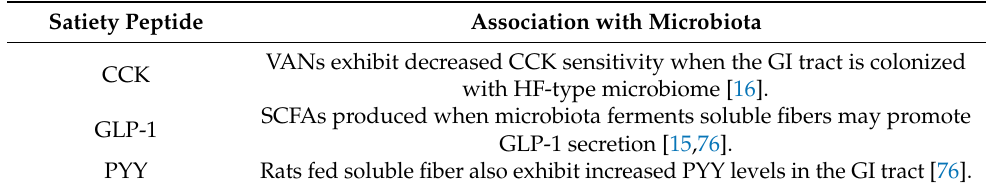
Table 1. Gastrointestinal (GI) satiety peptides and their association with